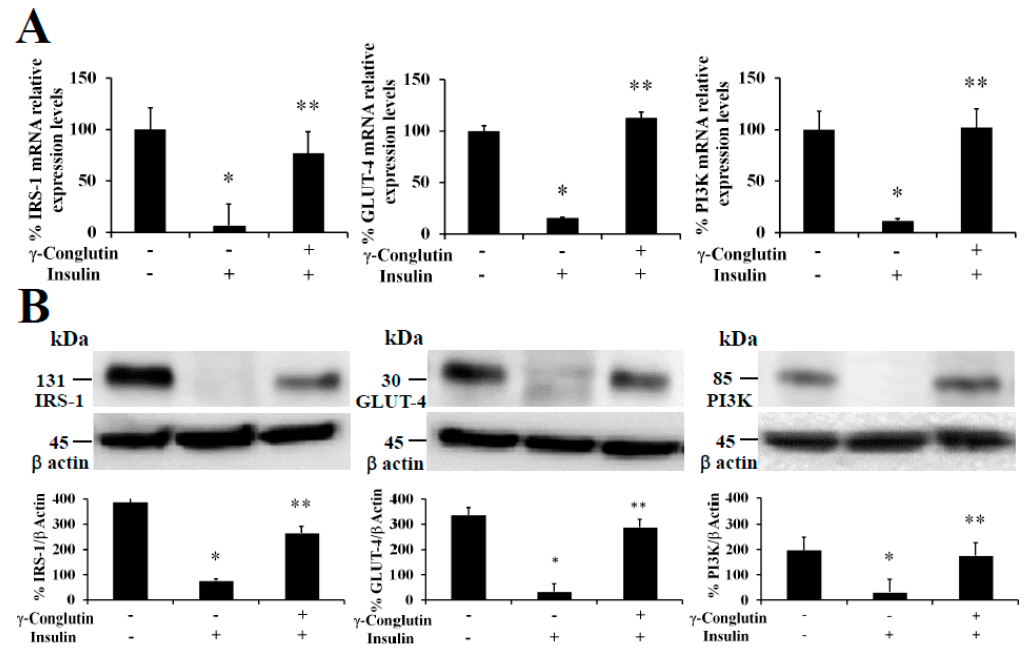
Figure 5. NLL γ -conglutin increases mRNA expression and protein levels of the insulin signaling pathway mediators IRS-1, PI3K and GLUT-4. PANC-1 cells or IR-C cell culture were incubated for 24 h alone, or the former culture with γ -conglutin. ( A ) The bar graph shows mRNA levels determined by real-time RT-qPCR of IRS-1, PI3K and GLUT-4. ( B ) The bar graph shows protein levels determined by immunoblotting of IRS-1, PI3K and GLUT-4. Average value from triplicate experiments of each biomarker were relativized to the average value of their housekeeping actin protein in control samples. Then, average values from challenge experiments (calculated in the same way than controls) are relativized to these from their respective control values previously calculated. Data represent mean ± SD from three independent experiments. Control: Untreated control PANC-1 culture cells; IR-C: insulin resistant culture cells; IR-C + γ : IR-C + γ -conglutin challenge. p < 0.05 represents statistically significant differences associated with each figure. p * < 0.05 IR-C versus control PANC-1 cells; p ** < 0.05 IR-C + γ -conglutin versus IR-C. Challenges were made with 25 μ g of γ -conglutin.